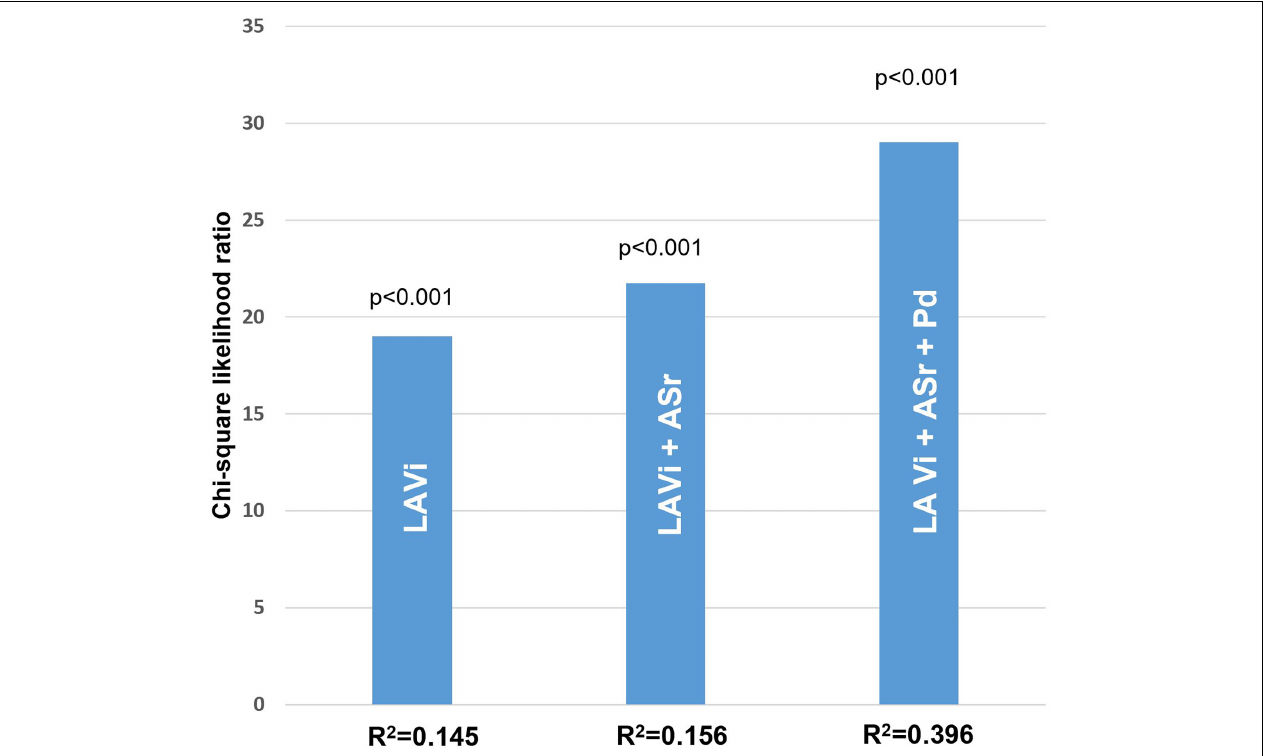
FIGURE 3 | Likelihood ratio test in the whole HCM population. Significant incremental predictive value for new-onset AF when adding ASr, further improving when adding both ASr and Pd (model accuracy of 85%) compared to a standard model taking into account only LA indexed volume (model accuracy of